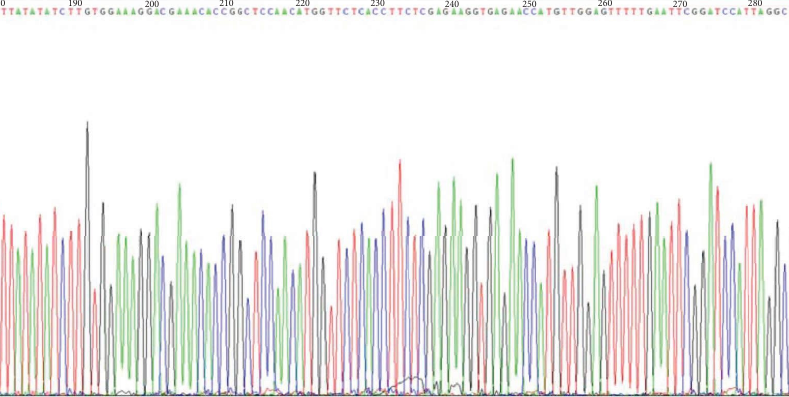
Figure 1: Analysis by Chromas sequencing software showed that the siRNA sequence was inserted correctly.